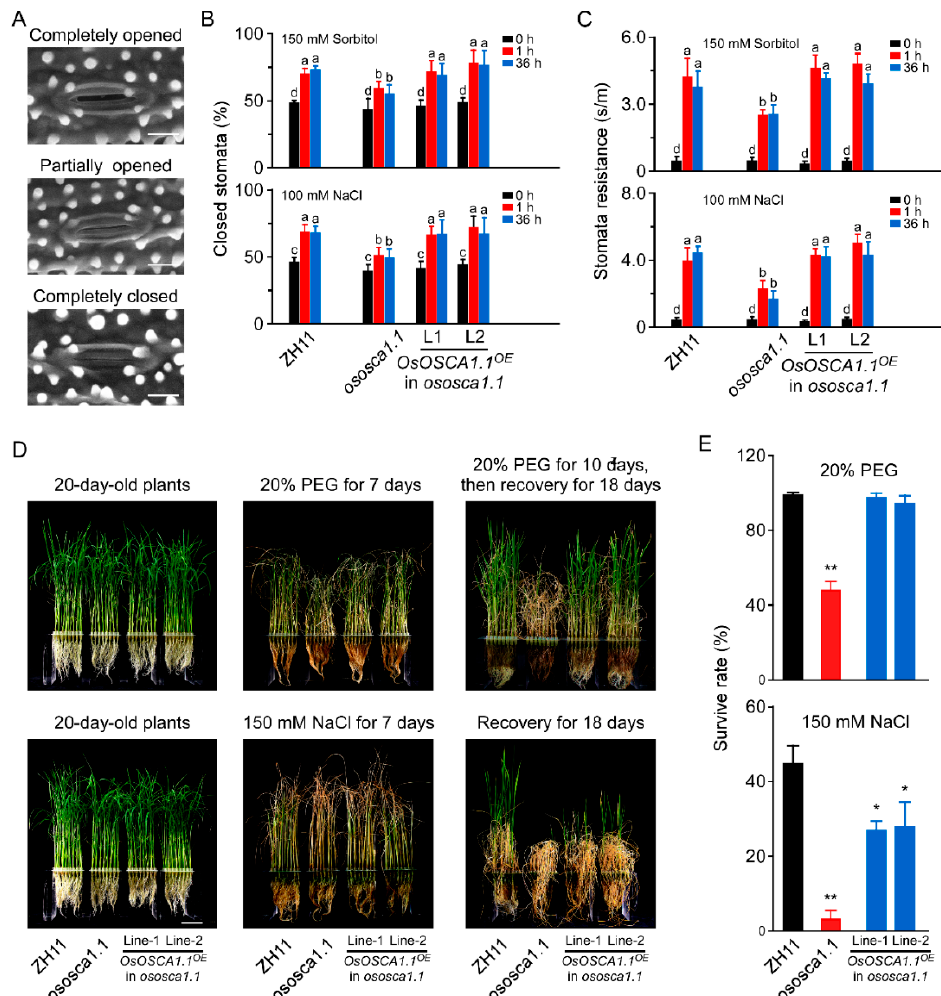
Figure 2. OsOSCA1.1 is essential for hyperosmolality- and salt-induced stomatal closure and sur- vival under hyperosmolality and salt stress conditions in rice. ( A ) Environmental scanning electron micrographs of opening/closing stomata on a 30-day-old rice blade. Scale bar = 10 μ m. ( B ) Percent- age of closed stomata in 30-day-old ZH11, ososca1.1 , and OsOSCA1.1- overexpressing ososca1.1 line 1 and 2 plants treated with 150 mM of sorbitol and 100 mM of NaCl for 1 and 36 h, respectively ( n = 130 stomata). Different letters indicate significant differences at p < 0.05 [one-way analysis of vari- ance (ANOVA)]. ( C ) Stomatal resistance of 30-day-old ZH11, ososca1.1 , and OsOSCA1.1- overex- pressing ososca1.1 lines 1 and 6 treated with 150 mM of sorbitol and 100 mM of NaCl for 1 and 36 h, respectively ( n = 12 leaves). a,b,c,d Different letters indicate significant differences at p < 0.05 (one-way ANOVA). ( D ) Images of 20-day-old ZH11, ososca1.1 , and OsOSCA1.1- overexpressing ososca1.1 lines 1 and 2 treated with 20% polyethyleneglycol (PEG) or 150 mM of NaCl for 7 days, followed by 3 more days of treatment and recovery for 18 days. ( E ) Survival rate of ZH11, ososca1.1 , and OsOSCA1.1- overexpressing ososca1.1 lines 1 and 2 treated with 20% PEG or 150 mM NaCl for 10 days, followed by recovery for 18 days ( n = 300 seedlings). * p < 0.05; ** p < 0.01 (Tukey’s test).